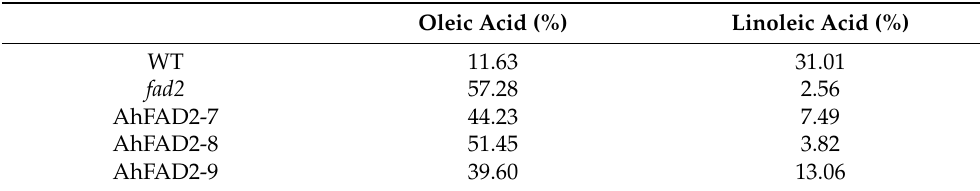
Table 2. Determination of fatty acids in transgenic Arabidopsis.